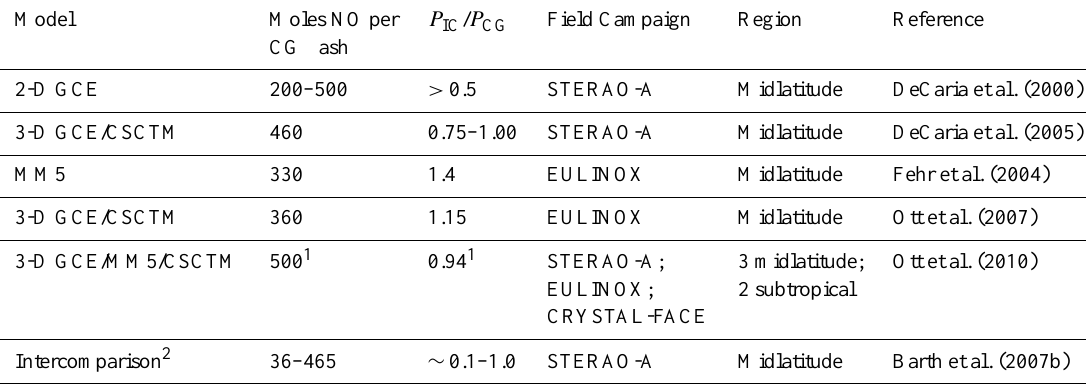
Table 1. Summary of cloud-resolved simulations of LNO x